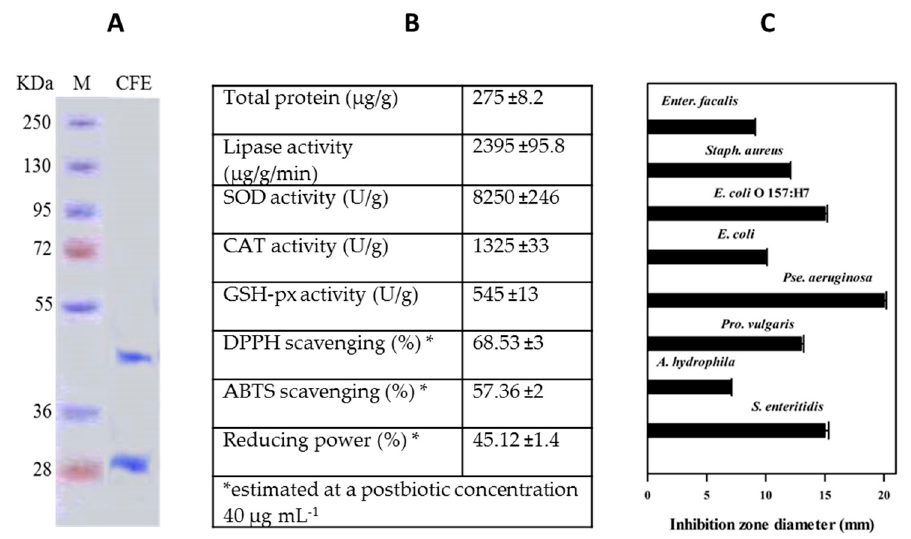
Figure 1. Biochemical information on Lactobacillus paracasei cell-free extract (postbiotic): electro- phoretic pattern ( A ), biochemical profile ( B ), and antibacterial activity ( C ). Values in ( B ) and ( C ) are presented as mean ± standard deviation (SD) ( n = 3).